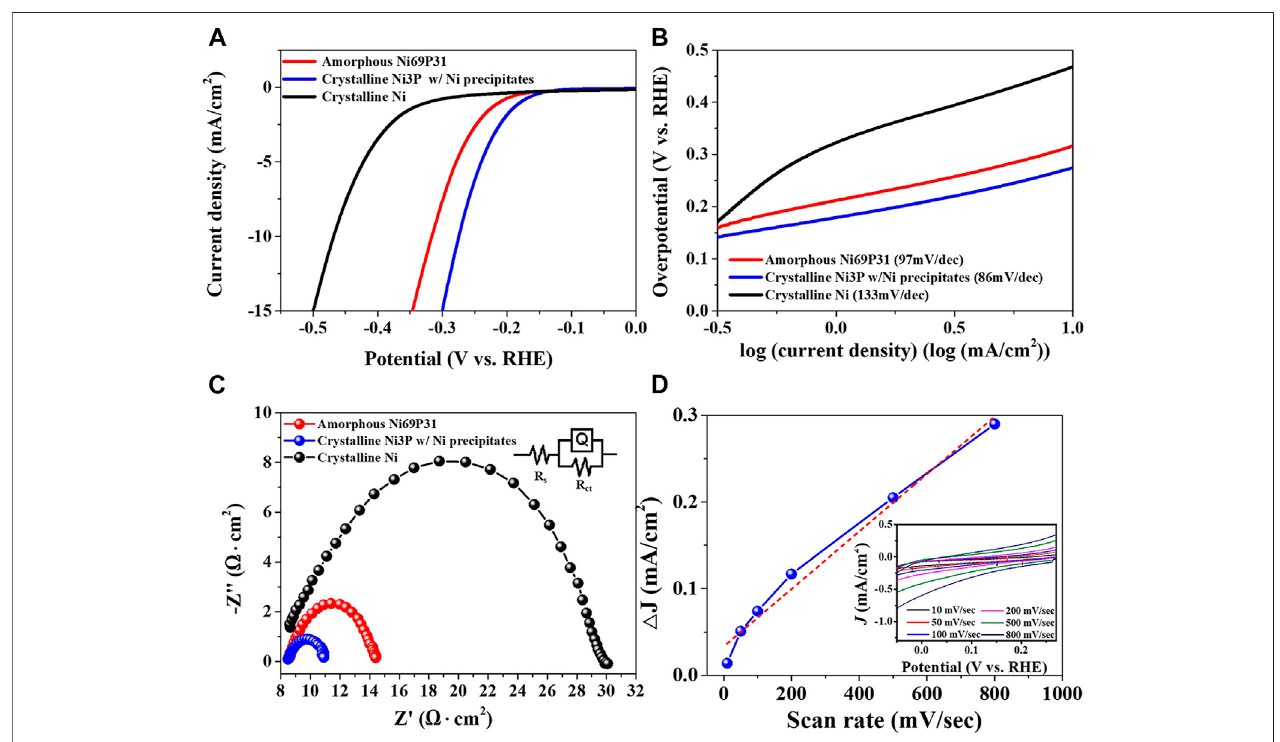
FIGURE 7 | Electrocatalytic properties of the crystalline Ni 3 P with elemental Ni inclusions prepared by annealing of amorphous Ni 69 P 31 electrodeposit: (A) polarization curves, (B) Tafel plots, (C) Nyquist plots, and (D) ECSA estimation based on the capacitive current at 250 mV (vs. RHE) (inset: cyclic voltammograms crystalline Ni 3 P with elemental Ni inclusions as a function of scan